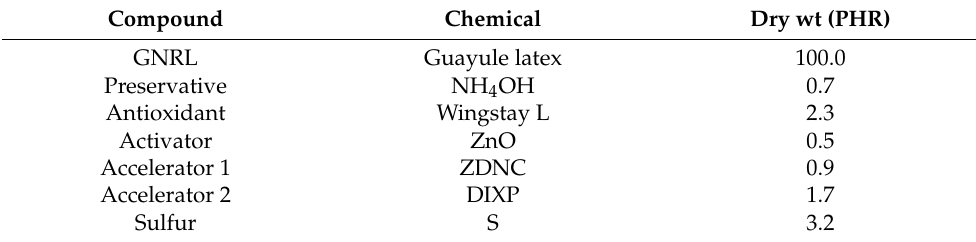
Table 1. Recipe for GNRL compounding.